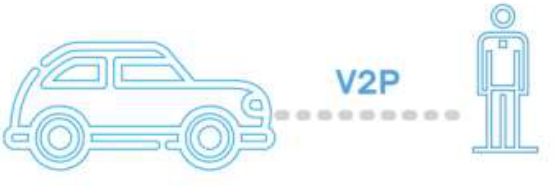
Figure 3. ©V2P communication Copyright 2017, 5GAA